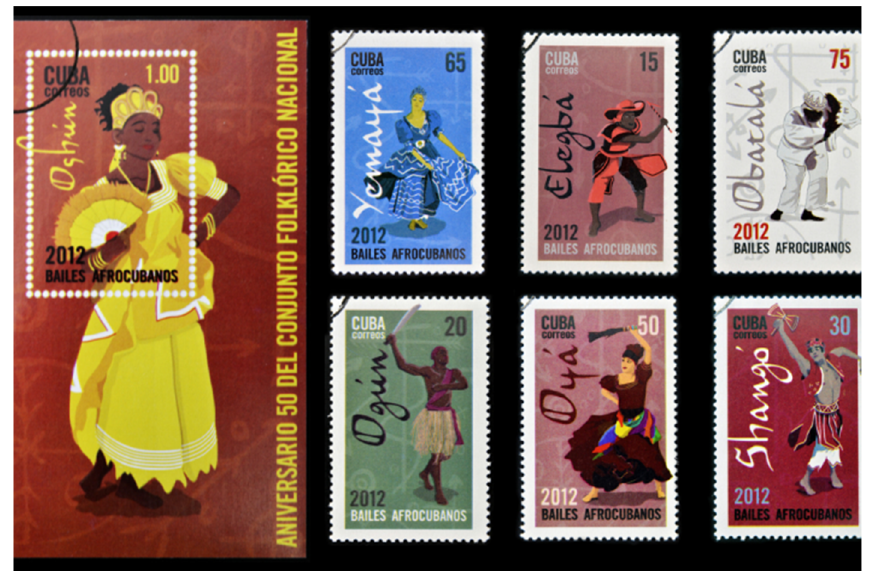
Figure 1. Orisha -themed postage stamps published by the Cuban government in 2012 to honor the Figure 1. Orisha ‑themed postage stamps published by the Cuban government in 2012 to honor the 50th anniversary of the Conjunto Folklórico Nacional de Cuba (aka the National Folkloric Ensemble 50th anniversary of the Conjunto Folkl ó rico Nacional de Cuba (aka the National Folkloric Ensemble of Cuba, or CFN). of Cuba, or